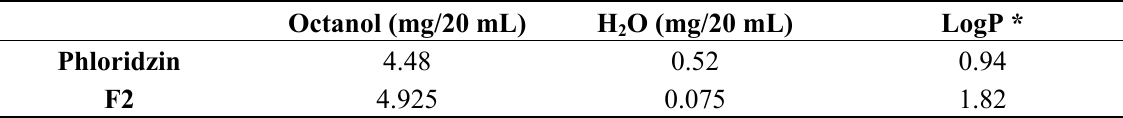
Table 1. Partition coefficients of phloridzin and F2 in a biphasic mixture of octanol and water.